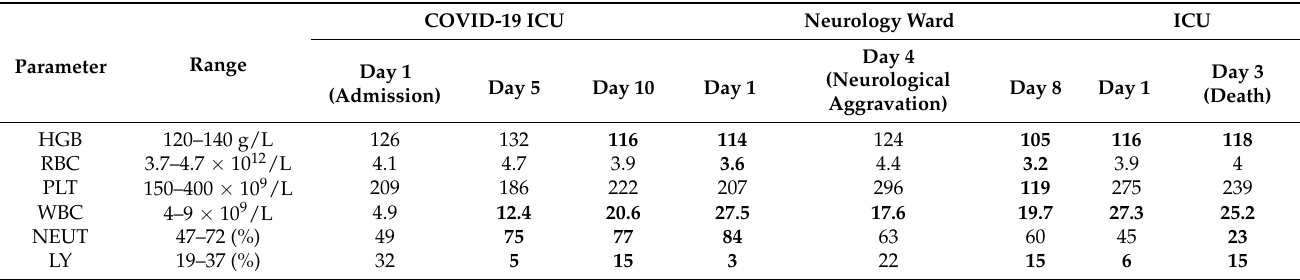
Table 1. Evolution of complete blood count parameters.